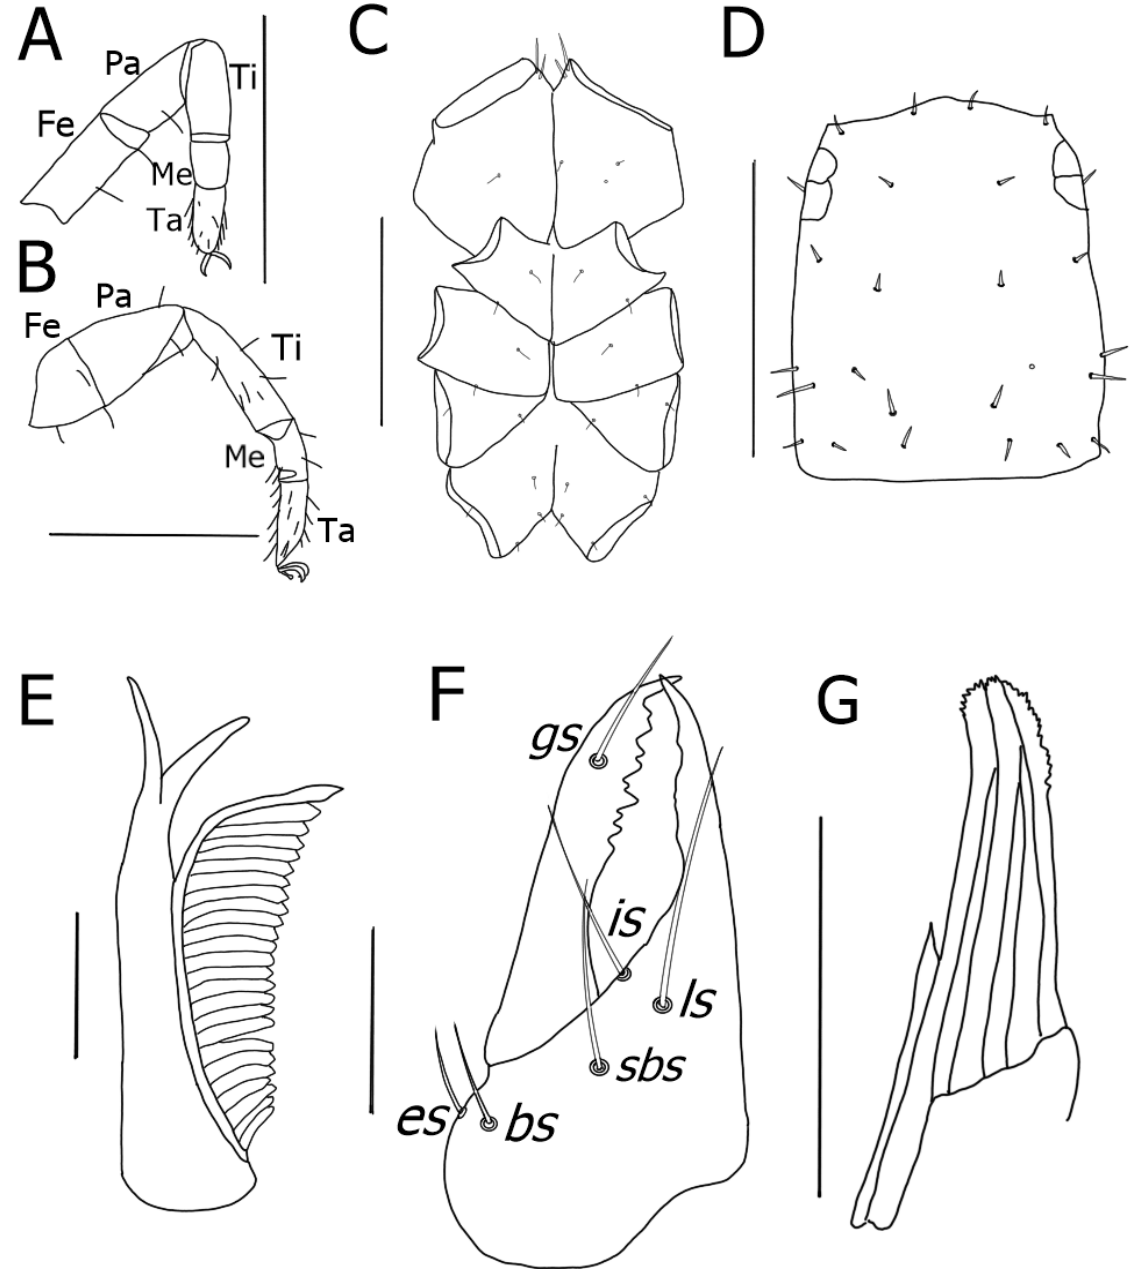
Fig. 12. Ideobisium sonqo sp. nov. A . Leg I. B . Leg IV. C . Coxa. D . Carapace. E . Serrula exterior. F . Chelicera in dorsal view, showing trichobothria. G . Rallum. A–D, F: holotype, ♂ (QCAZ); E, G: paratype, ♂ (ZMH A0003690). Abbreviations: Fe = femur; Pa = patella; Ti = tibia; Me = metatarsus; Ta = tarsus. Scale bars: A–C = 0.25 mm; D = 0.50 mm; E, G = 0.05 mm; F = 0.1